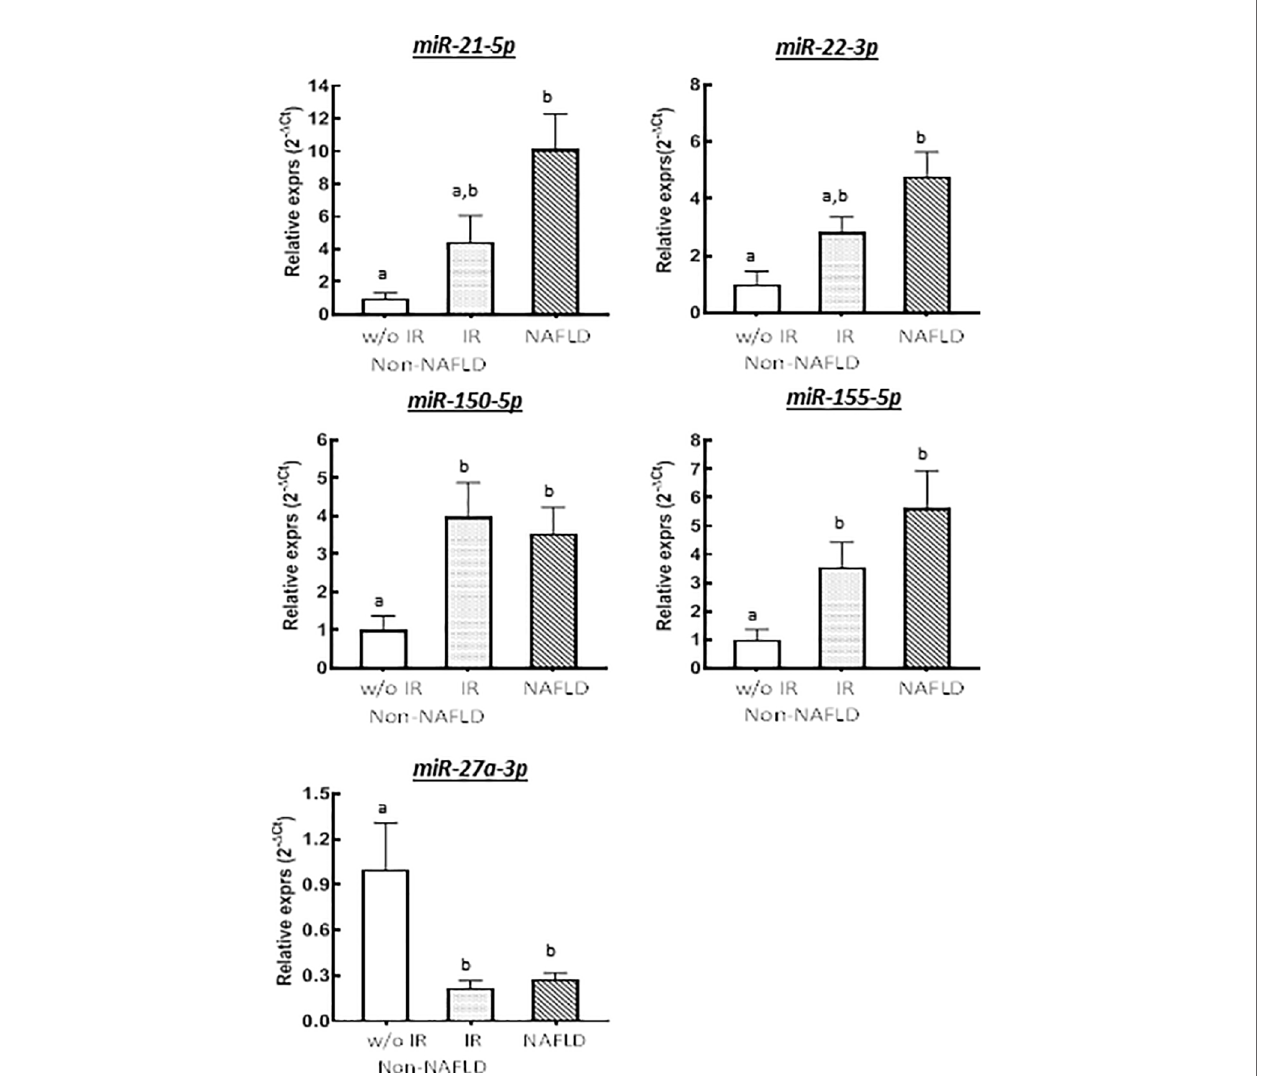
FIGURE 1 | Relative expressions of differentially expressed miRNAs across groups strati fi ed by IR and NAFLD status (n = 7 for Non-NAFLD without IR, n = 8 for Non-NAFLD with IR, and n = 15 for NAFLD groups). Group means were compared by one-way ANOVA. Labeled (a or b) means difference for comparison of two groups following the ANOVA analysis. Bars represent standard error of the